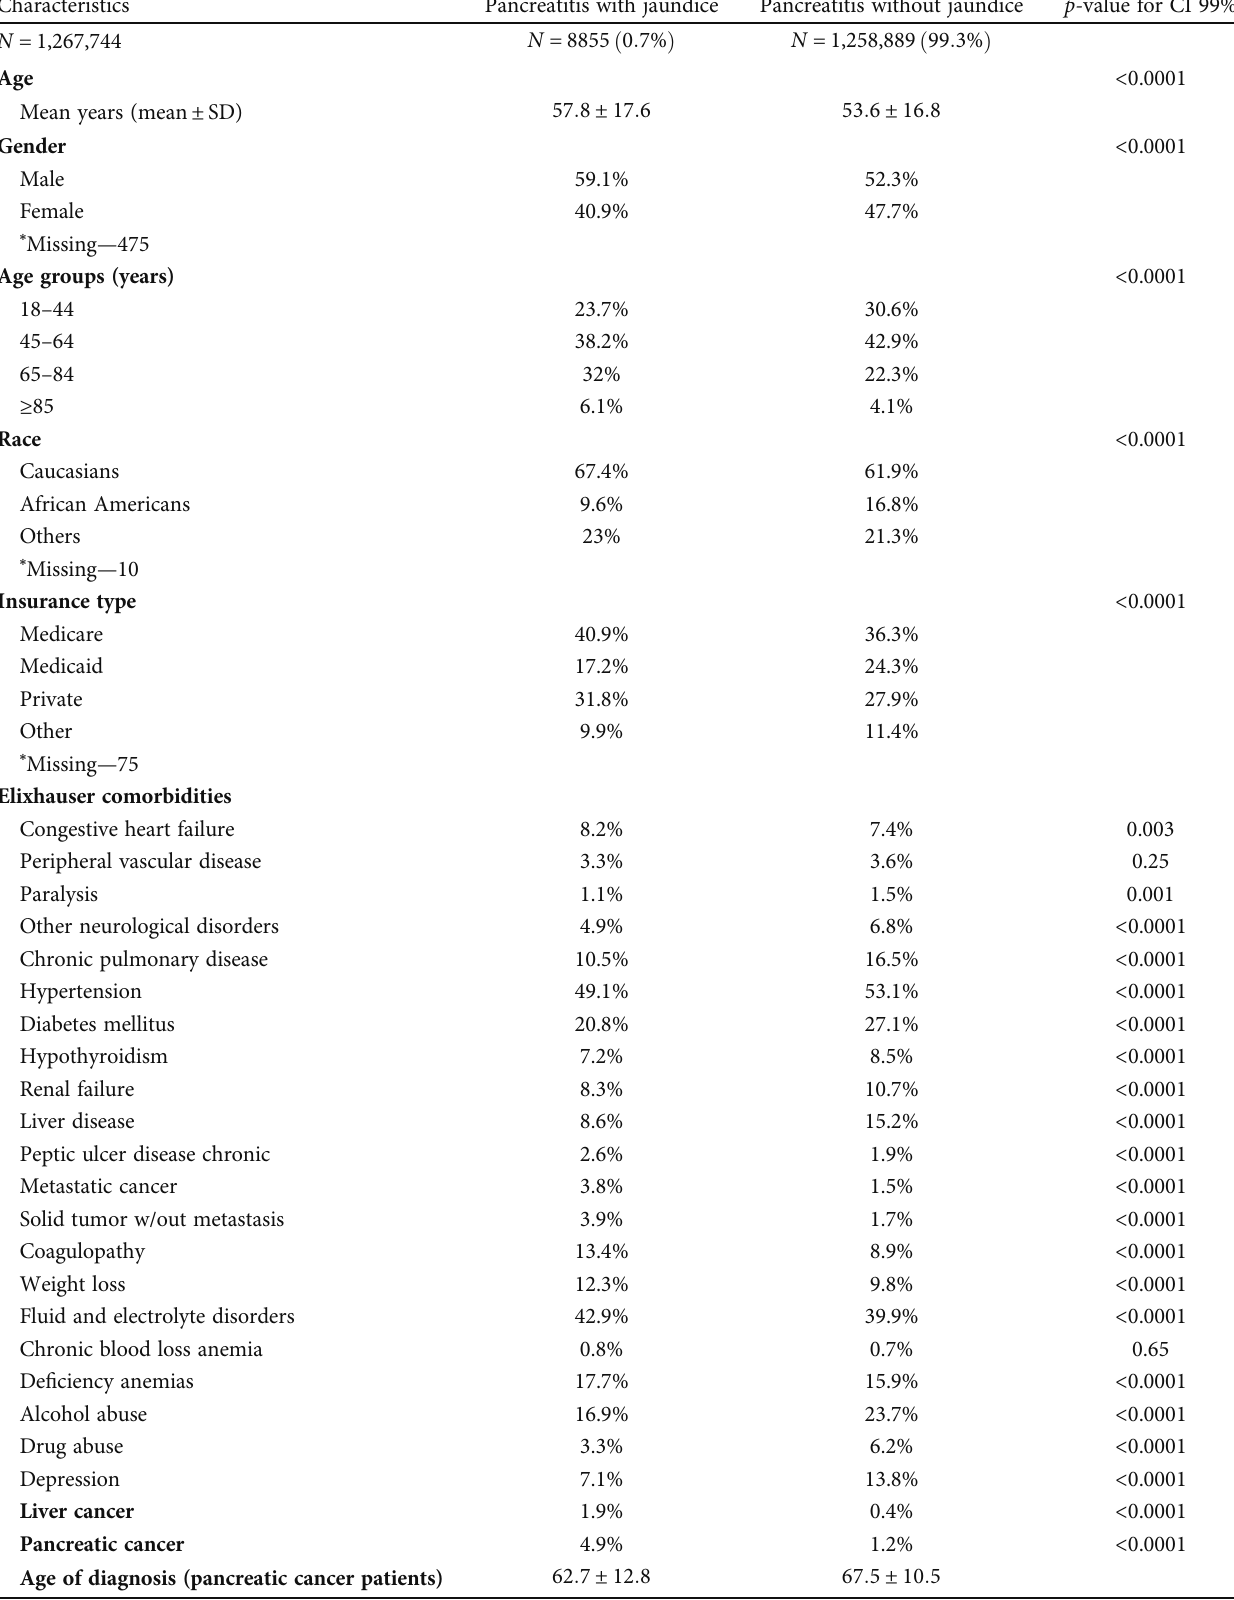
Table 1: Demographic characteristics of the two